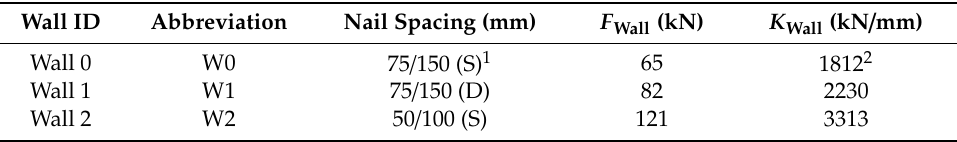
Table 2. Three light frame wood shear walls.